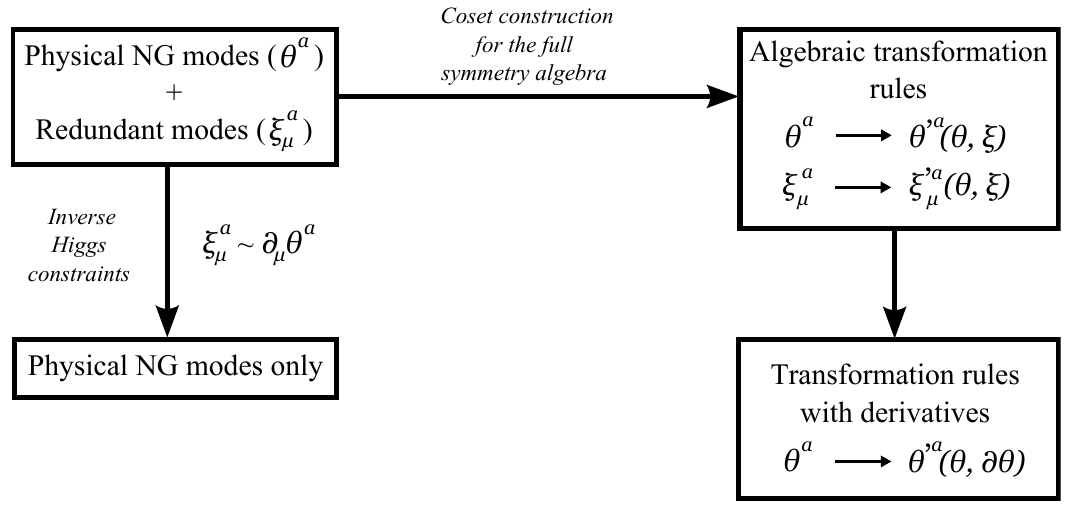
Figure 2 . The symmetry transformation rules are dictated by symmetry and the choice of param- eterization of the coset space, and never contain derivatives: they are purely algebraic functions of the coset space coordinates, that is, (cid:12)elds and spacetime coordinates. Transformation rules con- taining derivatives of the (cid:12)elds can only appear once the redundant modes have been eliminated using a set of inverse Higgs constraints. (The same argument was put forward recently in ref.